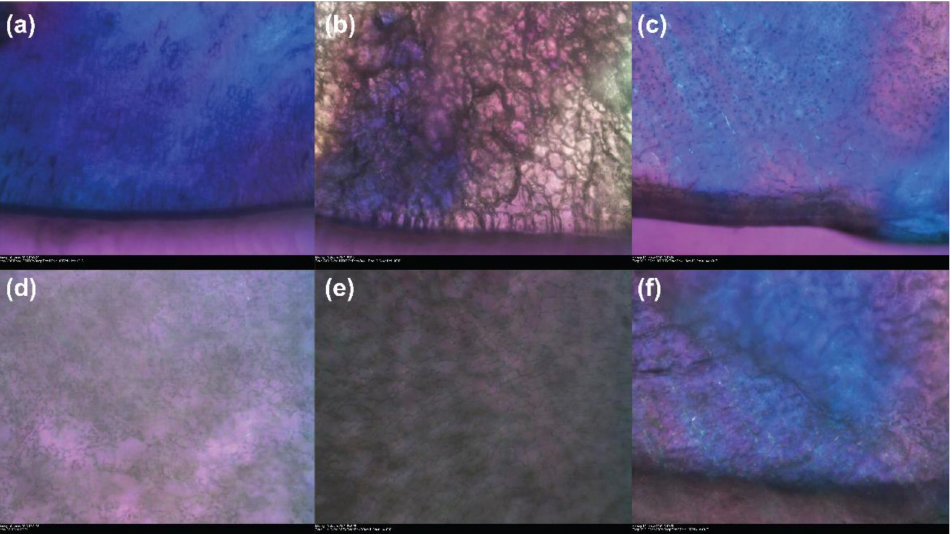
Figure 1. Images taken directly after freezing ( a – c ) and during freeze-drying ( d – f ) with a freeze- drying microscope of 1 wt.% solutions of chitosan ( a , d ), alginate ( b , e ) and cellulose nanocrystals ( c , f ), magnification 65 ×